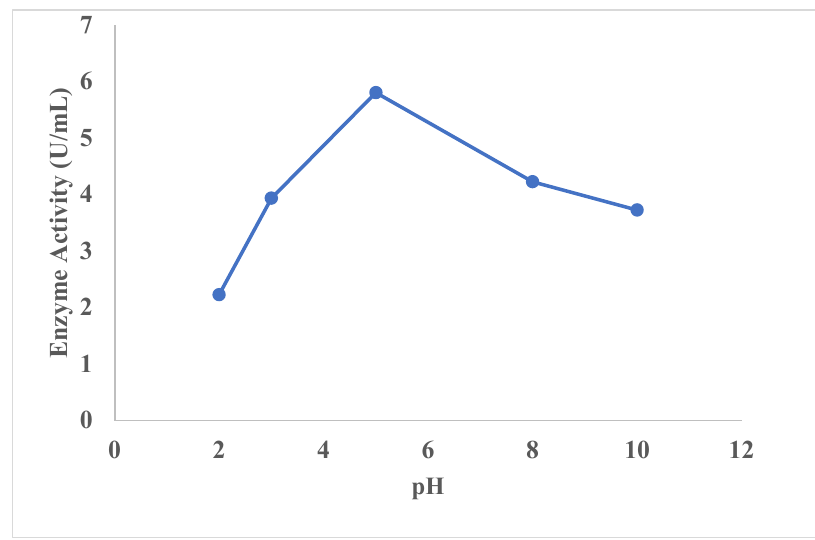
Figure 11. Laccase activity (U/mL) at different pH